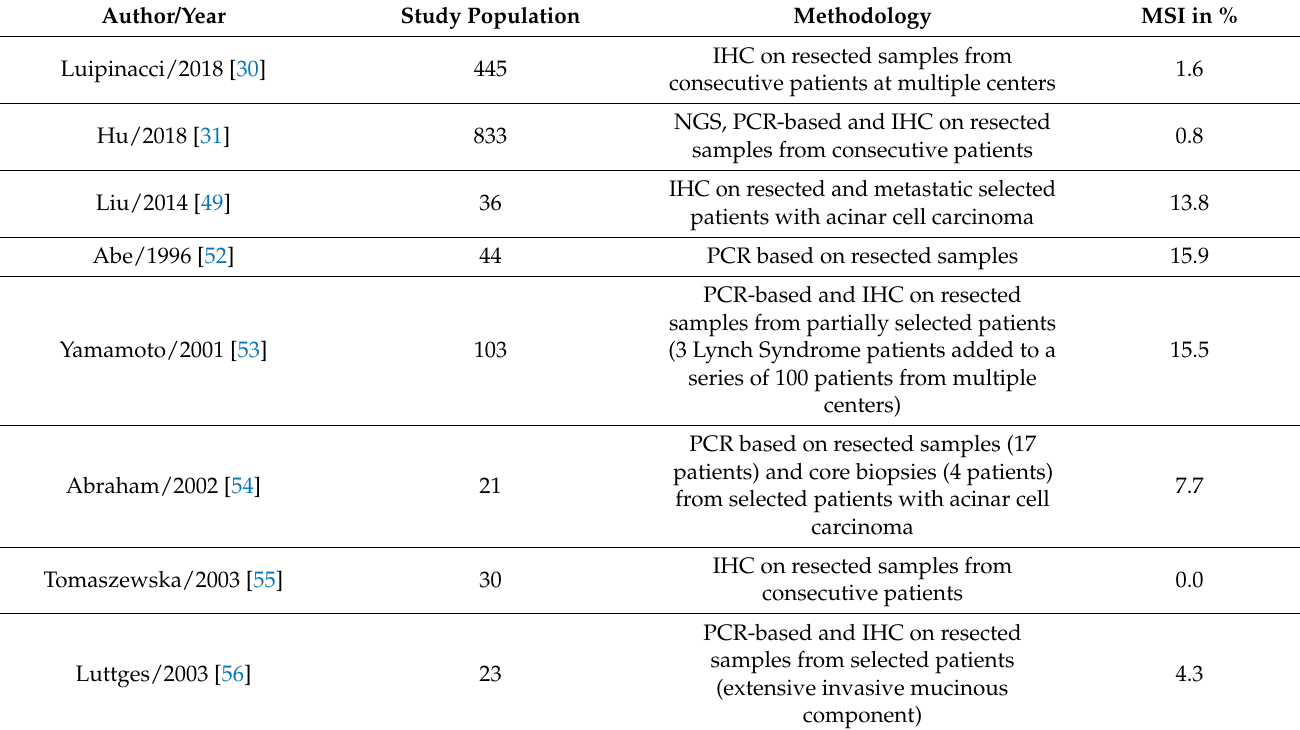
Table 1. Major studies assessing MSI in pancreatic